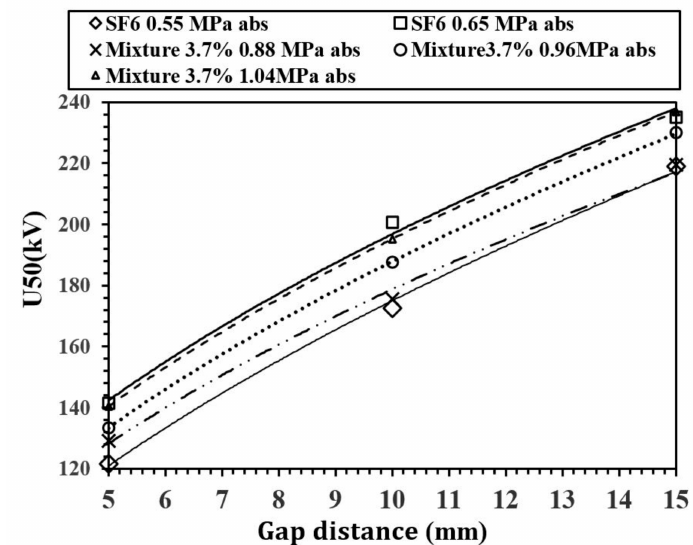
Figure 13. Negative LI breakdown voltages of 3.7% fluoronitriles/96.7% CO 2 mixture and pure SF 6 at different pressures versus the sphere-to-plane electrodes gap